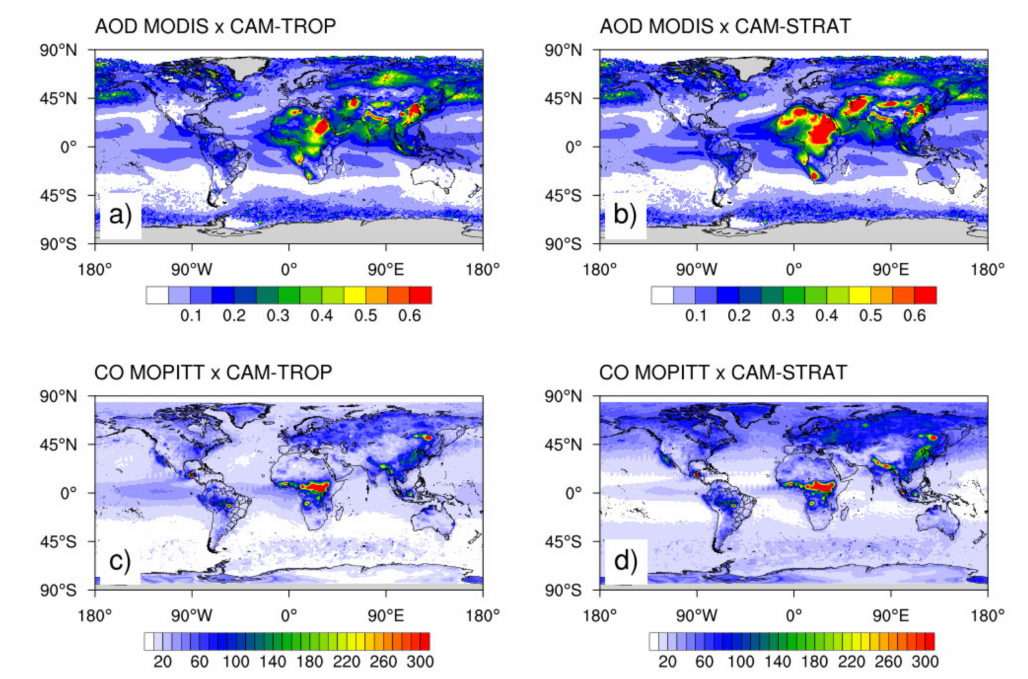
Figure 12. Root mean square error (RMSE) maps of annual average simulated AOD ( a , b ) and CO (ppb) ( c , d ) in both model configurations relative to the observations.